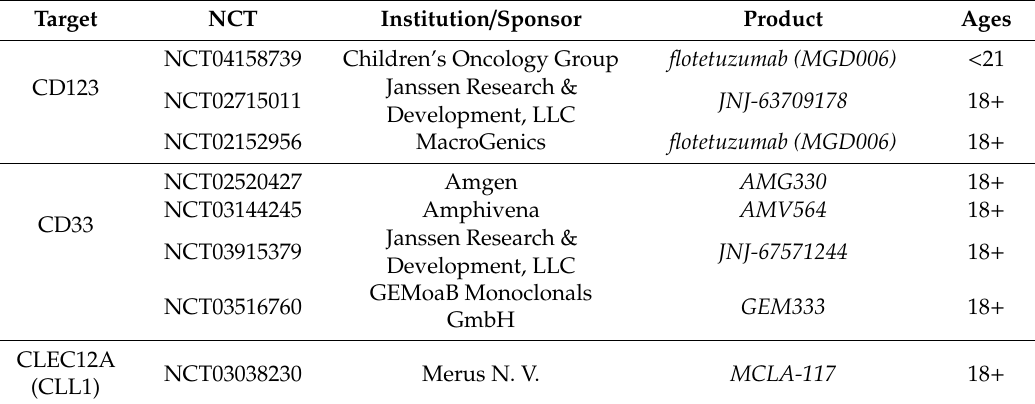
Figure 1. Strategies to Harness T Cells for Immunotherapy of acute myeloid leukemia (AML). CAR—chimeric antigen receptor, TCR—T-cell receptor, MHC—major histocompatibility complex. Table 1. Bispecific Antibody Clinical Trials for